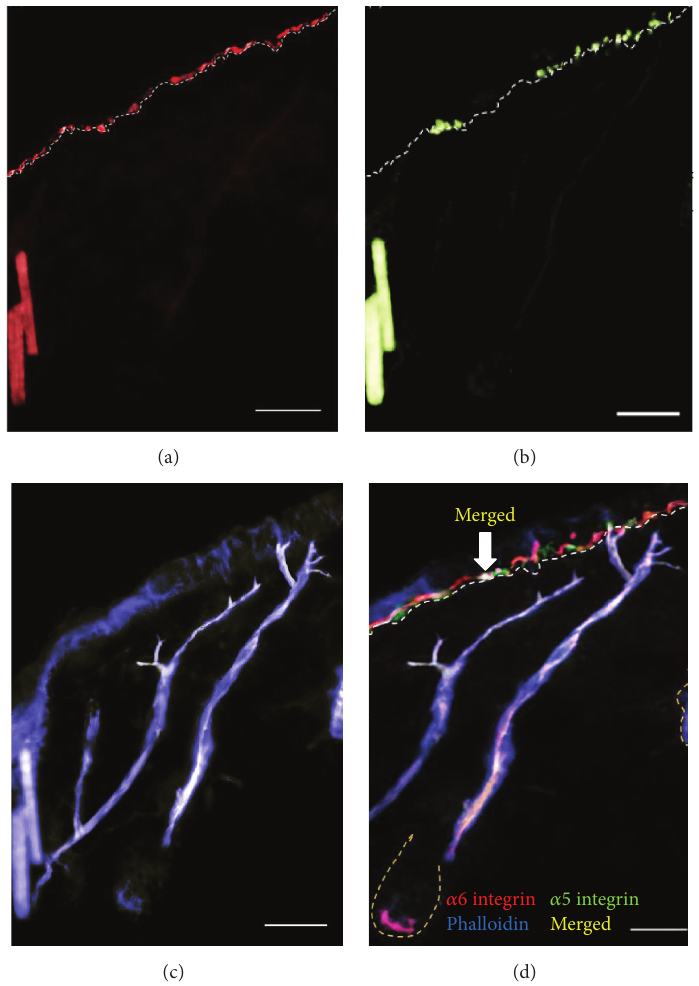
Figure 6: Localization of 𝛼 6 integrin in the interfollicular epidermis and follicle. Immunofluorescence microscopy showing patterns of expression of 𝛼 5 integrin, 𝛼 6 integrin, and phalloidin. (a) 𝛼 6 integrin (red) demonstrates a homogeneous expression in the basal epidermis. (b) Triple immunofluorescence staining for 𝛼 6 integrin (red), 𝛼 5 integrin (green), and phalloidin (blue) showing overlap of 𝛼 6 integrin and 𝛼 5 integrin expressing cells at the distal tips of the APM. (c-d) Due to the homogenous expression pattern of 𝛼 6 integrin it was deemed not to be a suitable marker for IFE stem cells. Scale bar: 100 𝜇